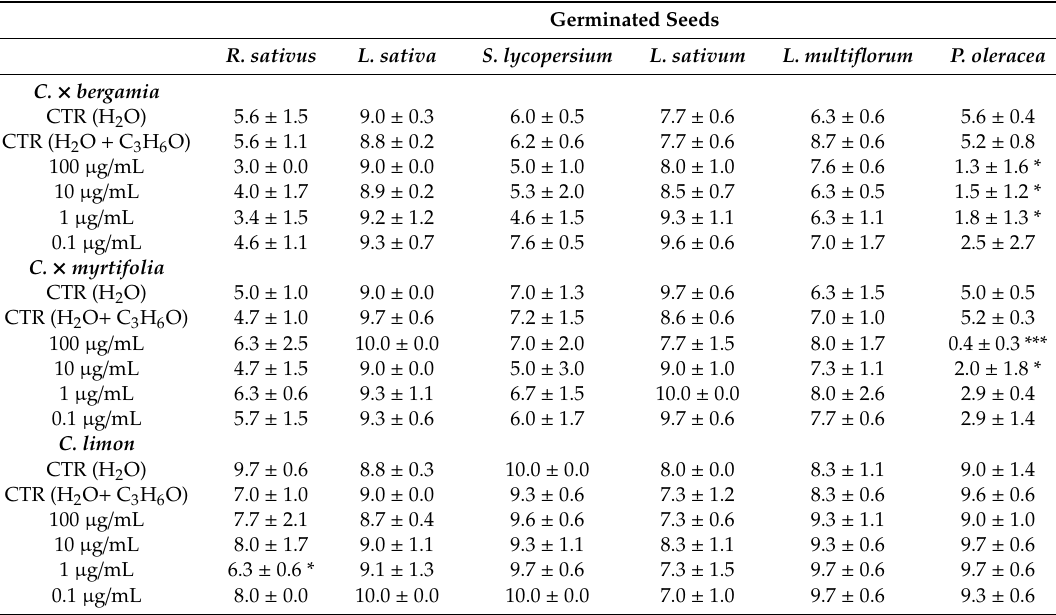
Table 4. Phytotoxic activity of the essential oils of C. × bergamia , C. × myrtifolia , C. limon against germination of R. sativus , L. sativa , S. lycopersium , L. sativum , L. multiflorum , and P. oleracea 120 h after sowing. Results are expressed as the mean of three experiments ± standard deviation.